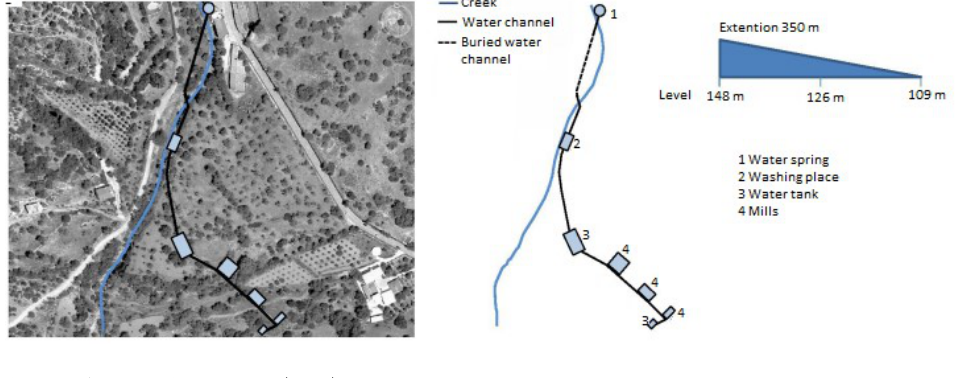
Figure 10: Hydraulic multifunctional system at Alface creek, north